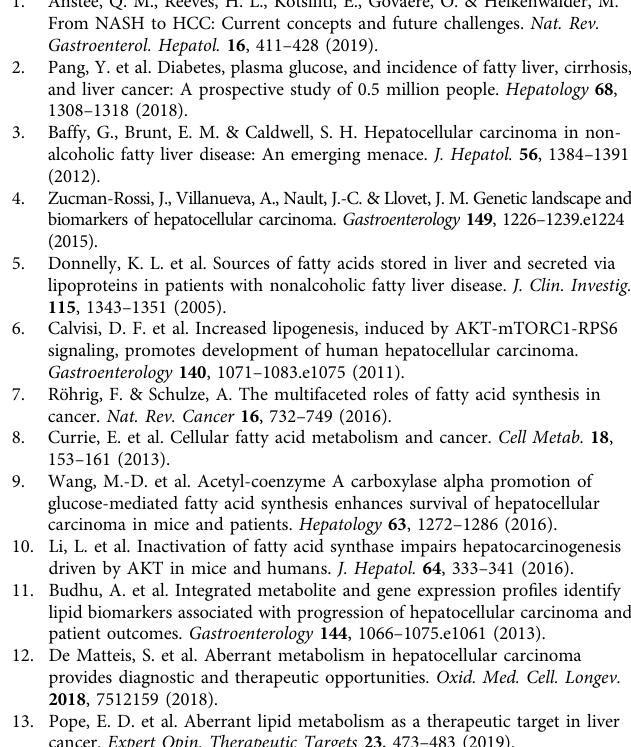
Table 2. The data used in this study for gene expression pro fi ling interactive analysis (http://gepia2.cancer-pku.cn) are available in The Cancer Genome Atlas (TCGA; https:// tcga-data.nci.nih.gov/). Promoter sequences are available from Eukaryotic Promoter Database (EPD; https://epd.ep fl .ch/). The reference library used in RNA-seq analysis (Mus musculus GRCm38.dna.primary_assembly.fa) is available in the GeneRIF (https:// www.ncbi.nlm.nih.gov/gene/?term = GRCm38). The source data underlying Figs. 1 – 3, 5 – 8 as well as Supplementary Fig 3 – 5, 7 and 8 are provided as a Source Data fi le. All the other data supporting the fi ndings of this study are available within the article and its Supplementary Information fi les. Source data are provided with this